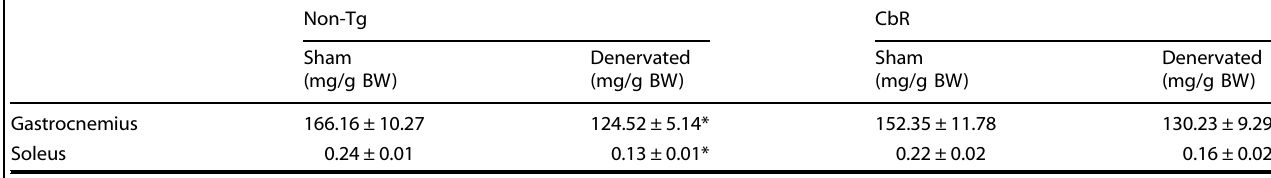
Table 3. Skeletal muscle weight of mice fed with Cblin peptide-enriched